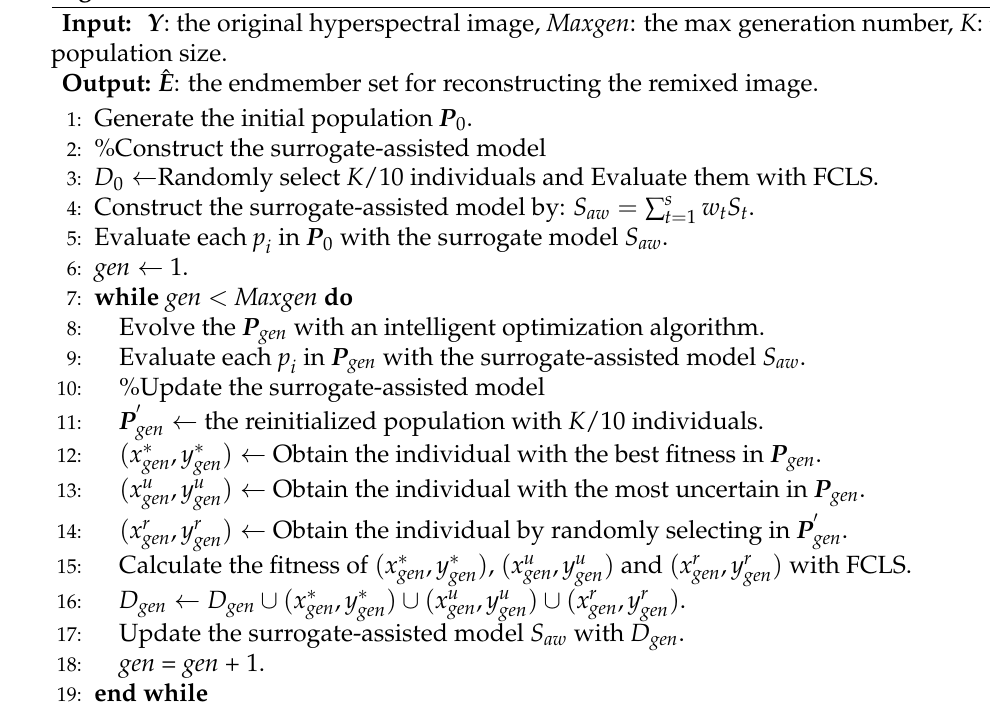
Algorithm 1 The ASAEE